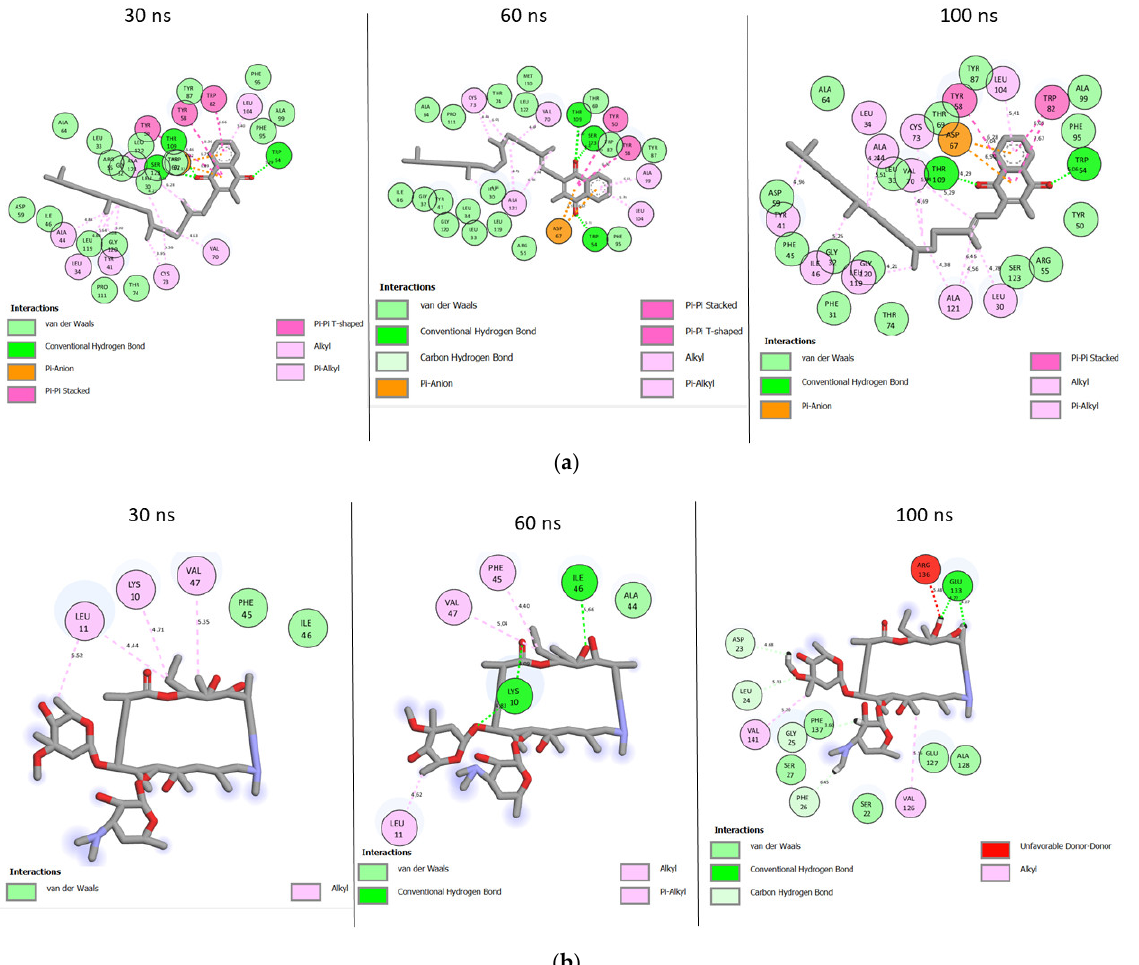
Figure 11. Plots of interactions at different intervals of ( a ) phylloquinone and ( b ) azithromycin against LasR during the 100 ns MD